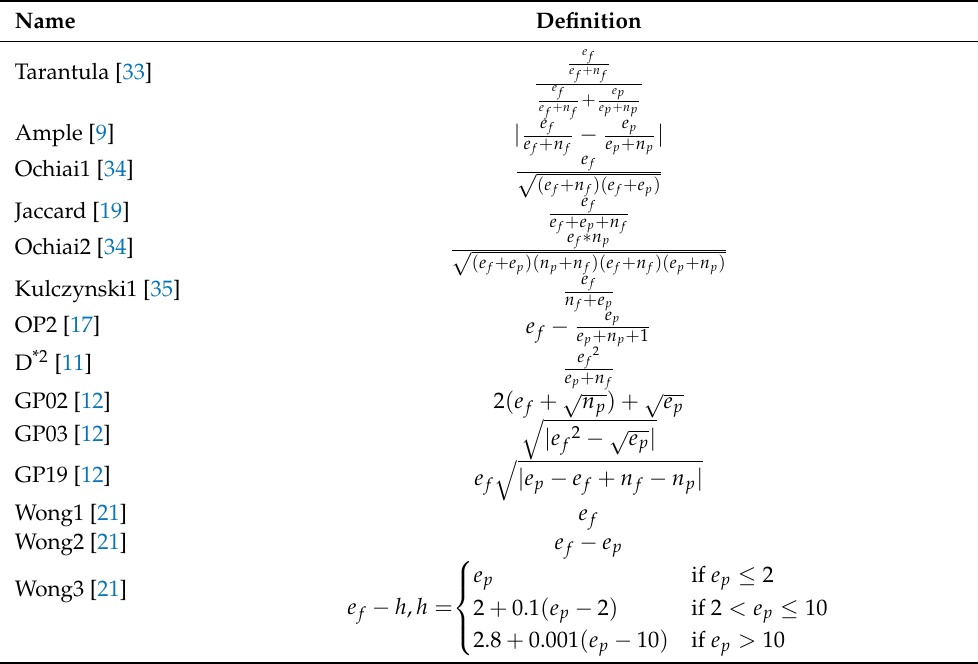
Table 1. The Maximal risk evaluation